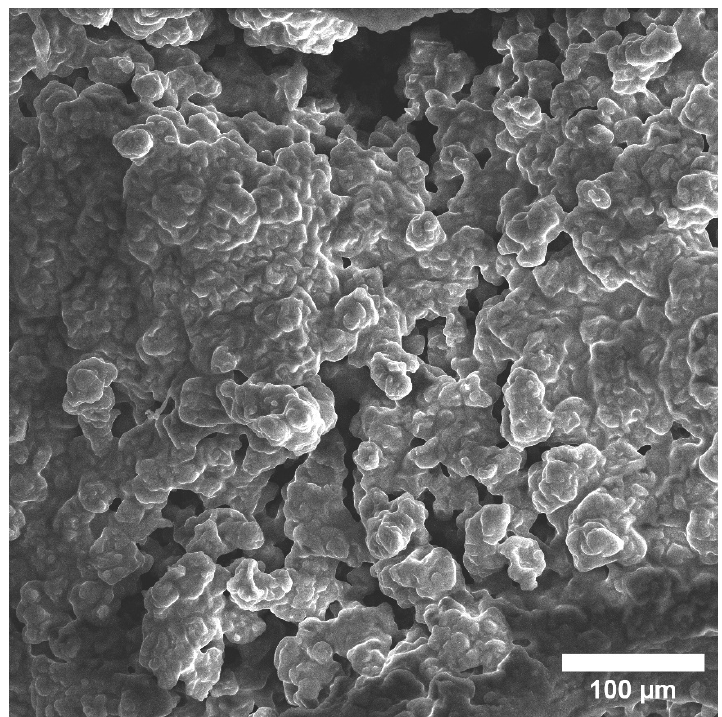
Figure 6. Enlarged SEM image of spherical discharge at implant site after 6 months.